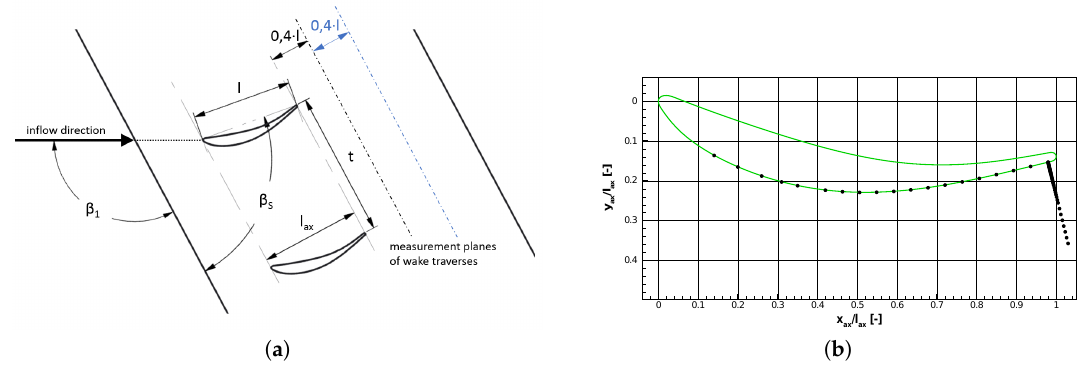
Figure 3. ( a ) Illustration of wake traverse measurement planes and ( b ) measurement positions of the flattened Pitot